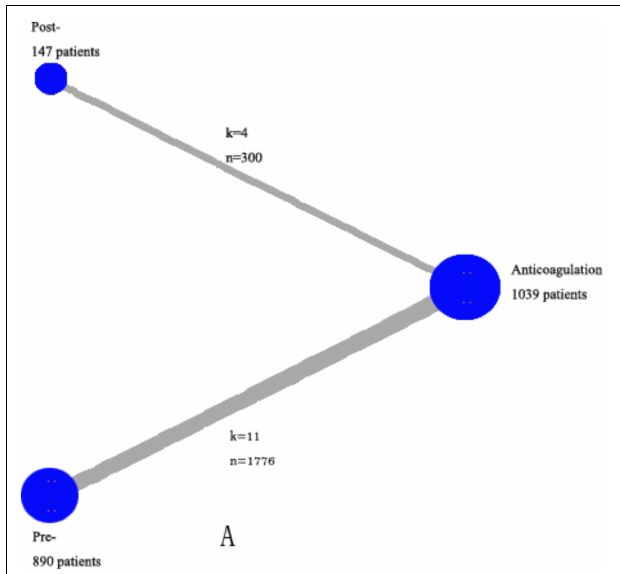
FIGURE 2 | Network of the comparisons for the Bayesian network analysis. The size of the nodes is proportional to the number of patients (in parentheses) randomized to receive the treatment. The width of the lines is proportional to the number of trials (beside the line) comparing the connected treatments. However, we excluded the trials in which both events in the experimental and control groups were 0 in specific analysis. k—number of trials per comparison; n—number of patients per